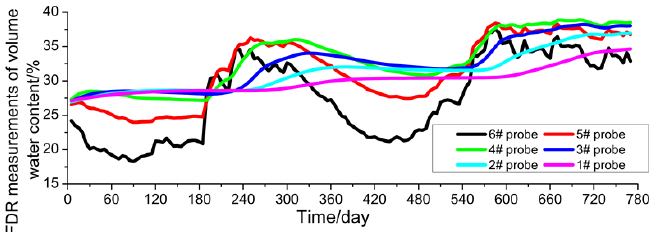
Figure 12. Volumetric moisture content obtained from the numerical simulation.